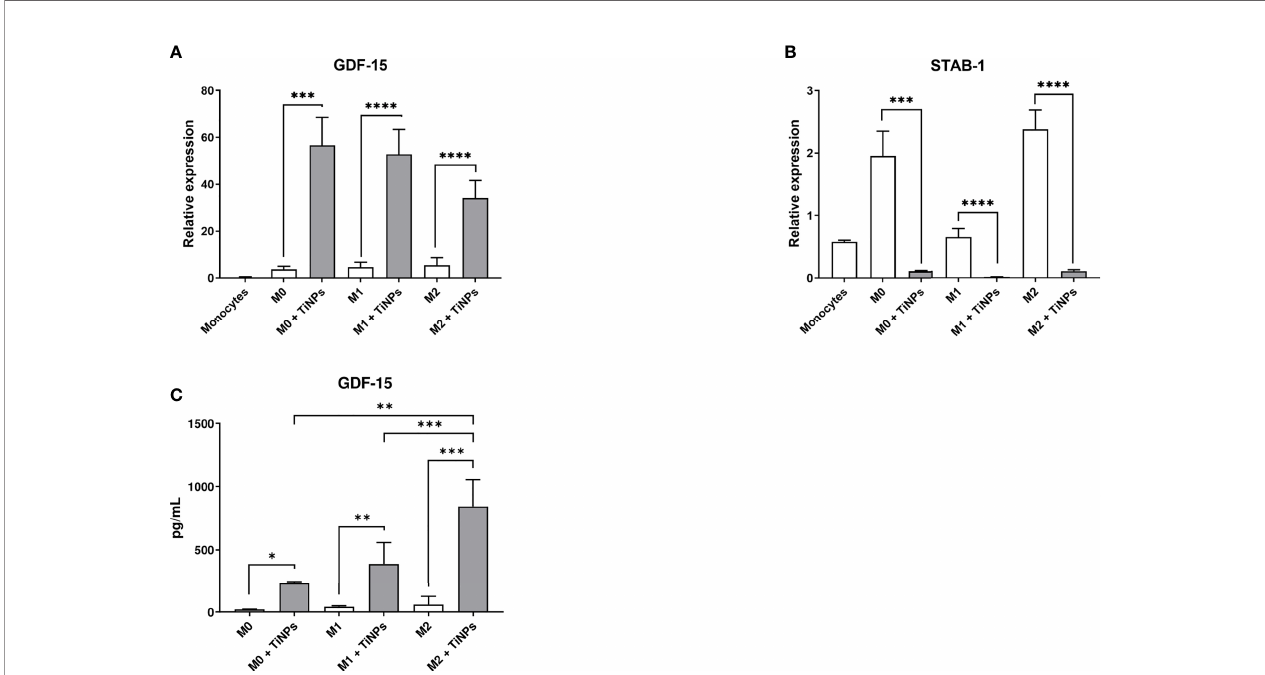
FIGURE 2 | Titanium nanoparticles have opposite effect on the expression of GDF-15 and stabilin-1 and strongly stimulate GDF-15 secretion in macrophages. mRNA levels were analyzed by RT-PCR in monocytes (day 0), and in non-stimulated (M0), M1 and M2 macrophages cultured for 6 days. (A) GDF-15 expression: n = 3 for monocytes, n = 7 for M0, n = 12 for M1, and n = 12 for M2. (B) Stabilin-1 expression: n = 4 for monocytes, n = 7 for M0, n = 12 for M1, and n = 12 for M2. (C) Supernatants of M0, M1 and M2 macrophages cultured for 6 days were analyzed by ELISA: n = 5 for M0, n = 10 for M1, n = 10 for M2. Error bars indicate the means standard error of the results normalized to 18SrRNA expression levels. *p < 0,05, **p < 0,01, ***p < 0,001, ****p < 0,0001.